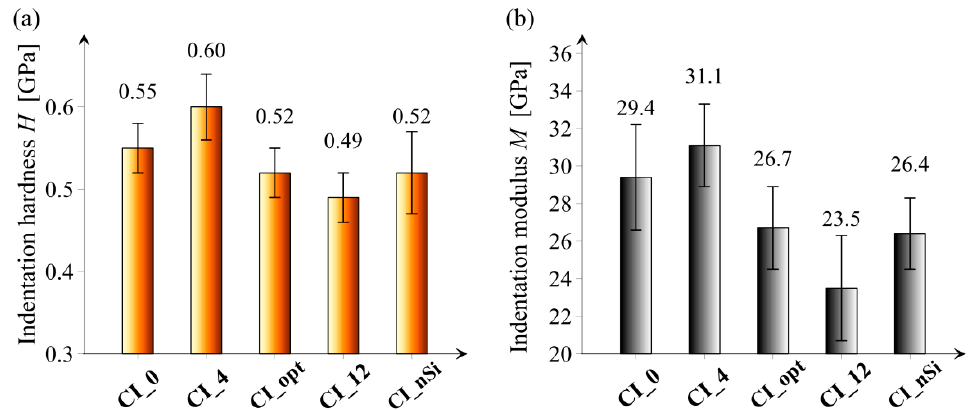
Figure 10. Results of: ( a ) hardness (H) and ( b ) indentation modulus (M) of all tested series. Vertical bars indicate one standard deviation.